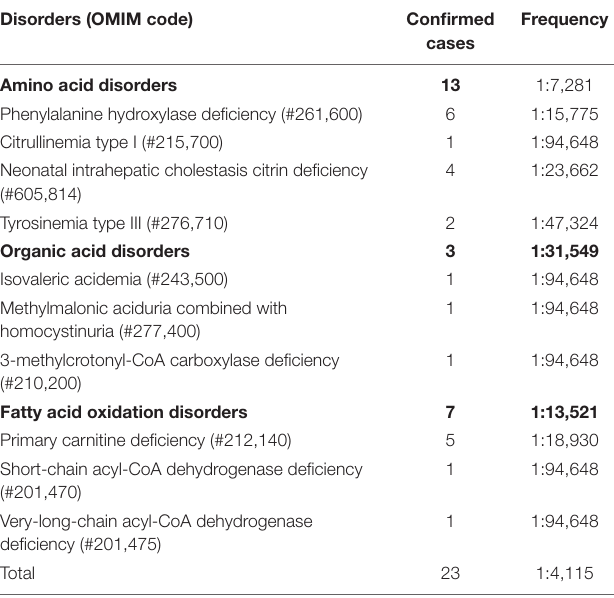
Frontiers in Pediatrics |